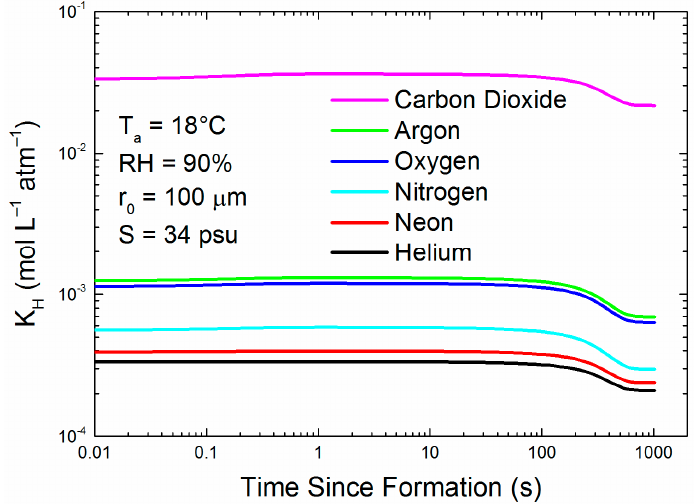
Figure 4. For each of the six gases, the figure shows how the Henry’s law coefficient changes for the evolving 100- μ m droplet tracked in Figure 1.